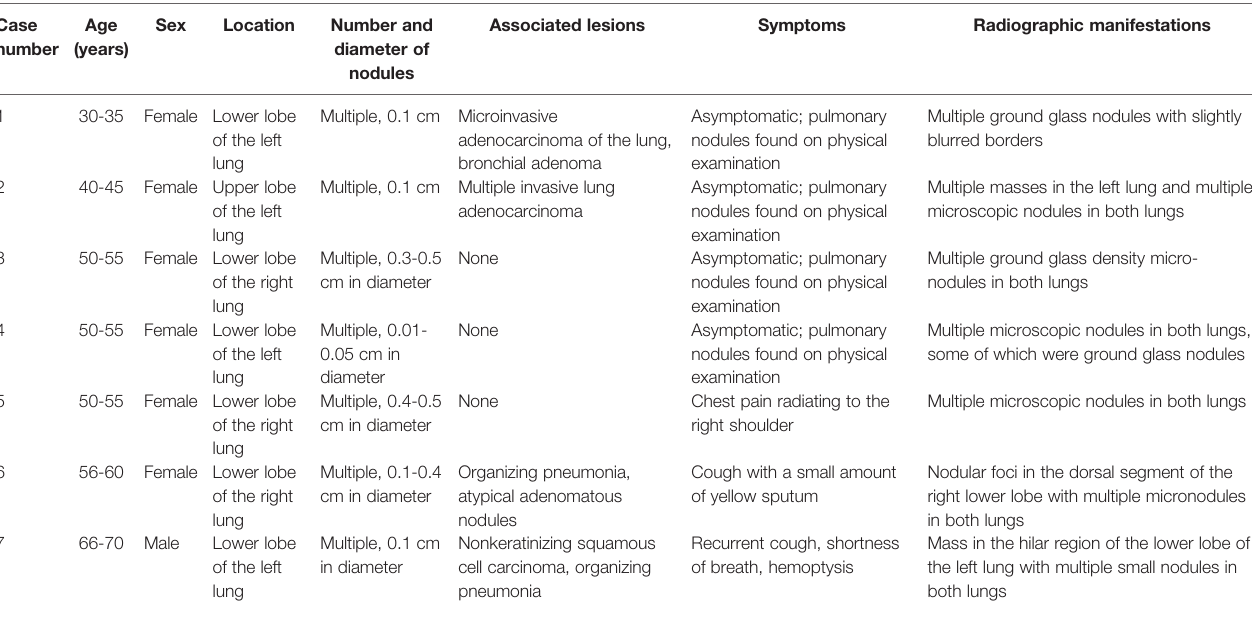
TABLE 1 | Clinical and Imaging data of 7 MPMN